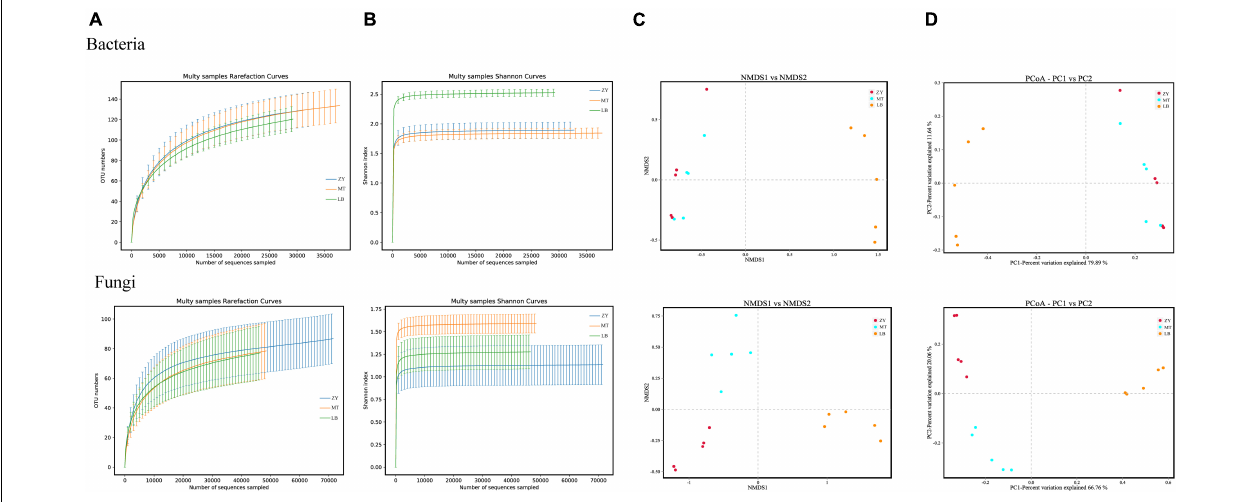
FIGURE 1 | (A) Variations in microbial diversity and community structure of SZR in three different regions. rarefaction curves of fungi and bacteria for each sample. (B) Shannon index curves of fungi and bacteria for each sample. (C,D) NMDS and PCoA score plots of bacteria and